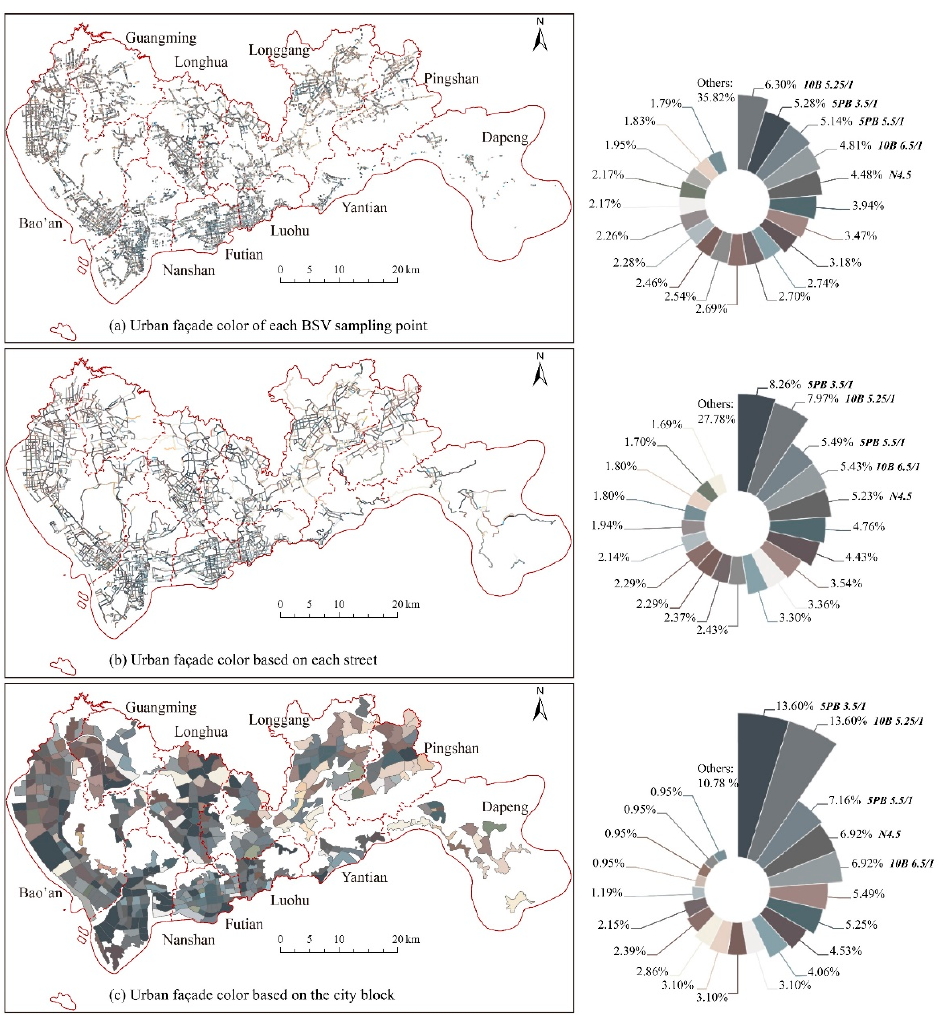
Figure 8. The mapping of the urban façade color in Shenzhen based on geographic units. ( a ) Urban façade color of each BSV sampling point, ( b ) urban façade color based on each street, ( c ) urban façade color based on the city block.